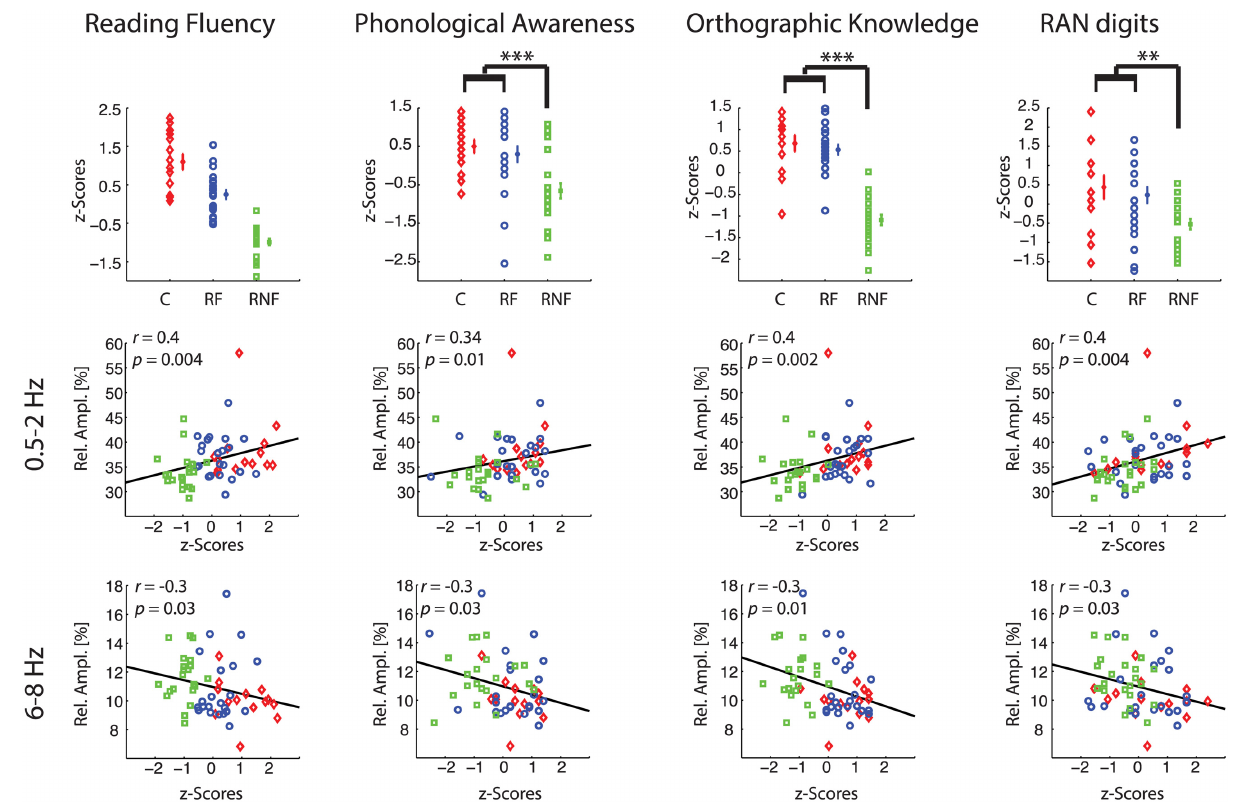
(composite measure of performance scores in word reading and pseudoword reading tasks) in the top left plot, all the groups statistically differ ( p = 0 . 001). The scatter plots in the remaining rows represent the correlations between individual-subject z-scores at each reading-related test and the individual-subject average across significant electrodes ( p < 0 . 05) of relative amplitude in delta-1 ( second row ), and in alpha-1 ( third row ). Statistics is based on n = 59